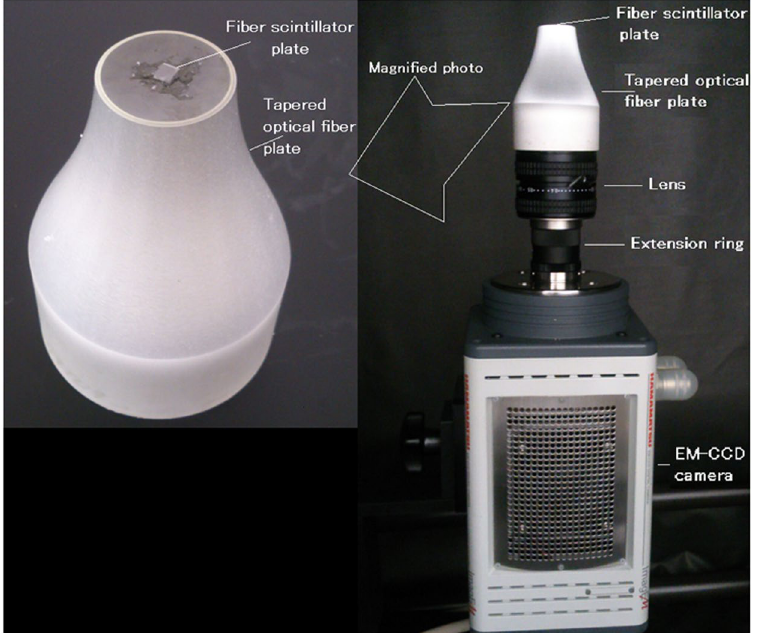
Figure 4. Developed ultrahigh resolution radiation imaging system; right side photo shows whole system and left side is its upper